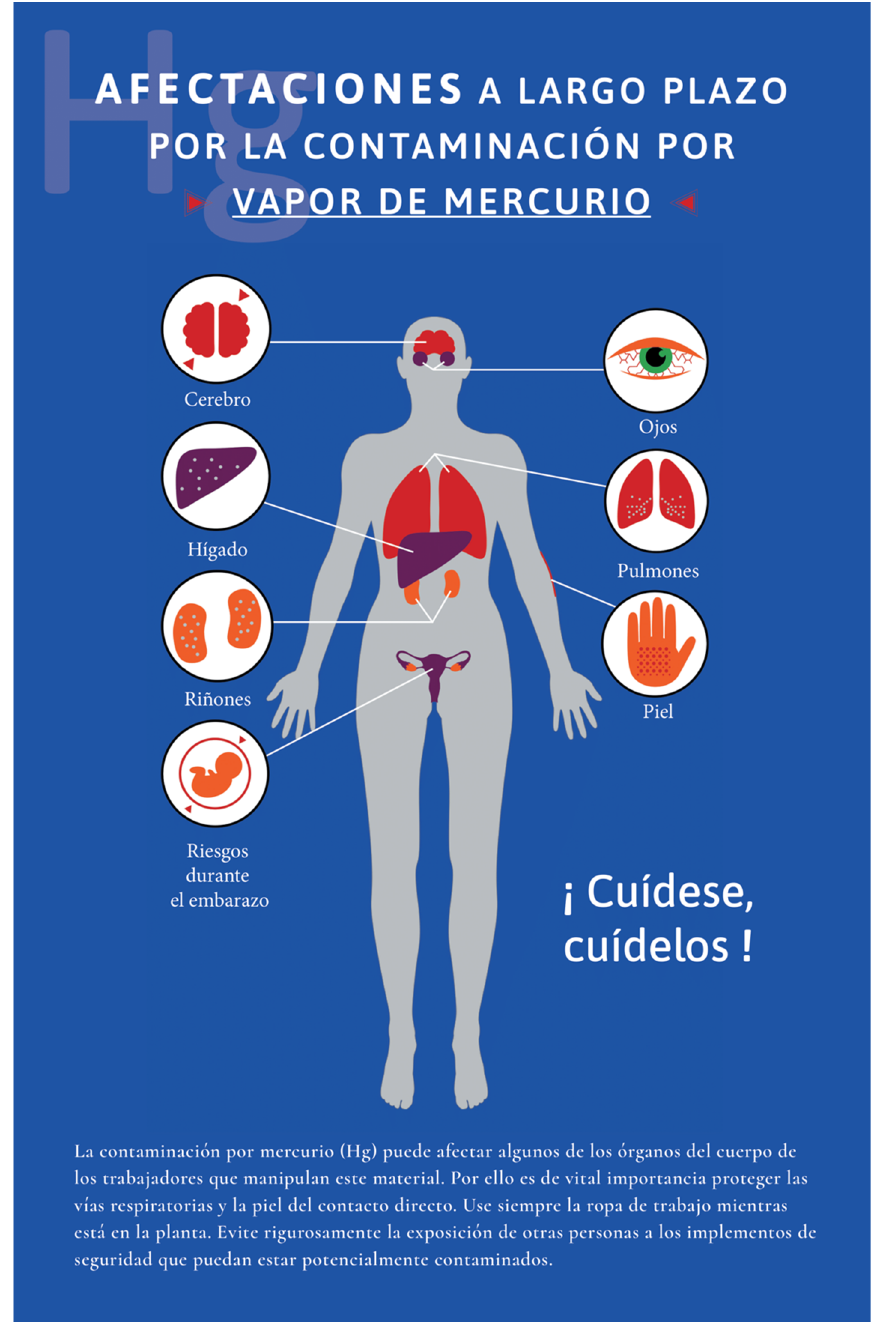
Figure 3. Public health infographics designed based on the findings of this study to visualize potential symptoms related to mercury exposure. Infographic created by Maria Carolina Cuestas Moncada, Juan David Reyes Estupiñan, and David Felipe Salazar Chiguasuque and reproduced with permission.